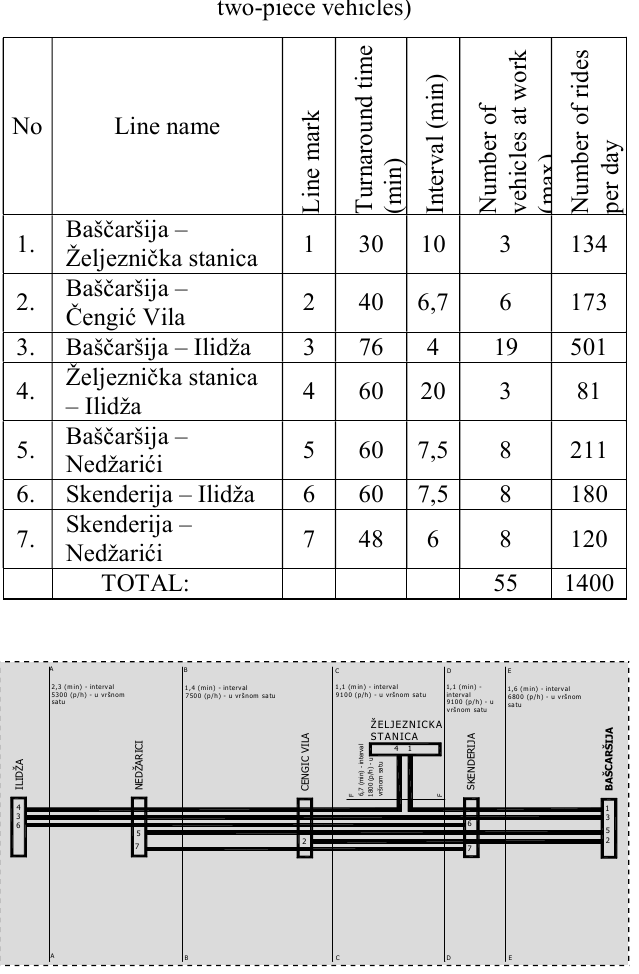
Figure 1. Characteristic cross-sections of tram sections